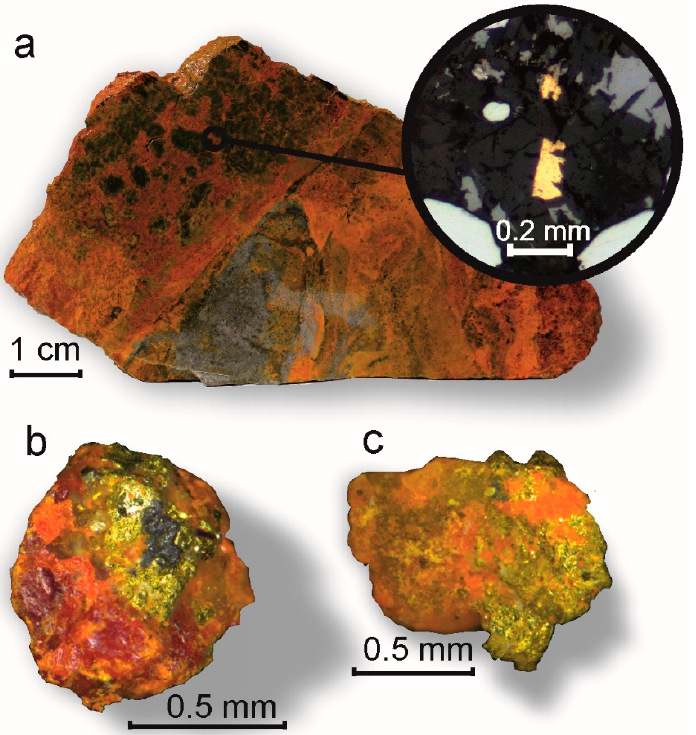
Figure 6. Native gold occurrences in ore breccias: ( a ) gold realgar-orpiment breccia with small pyrite grains and native gold, ( b ) native gold with realgar, ( c ) native gold with orpiment and calcite.